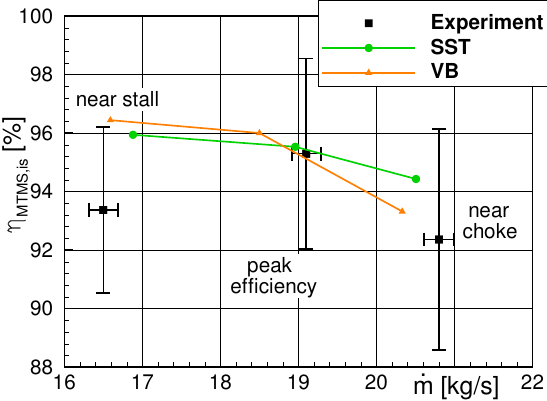
Figure 6. Isentropic-to-mechanical efficiency η MTMS,is over mass flow ˙ m for all three operating points, circumferential-averaged at